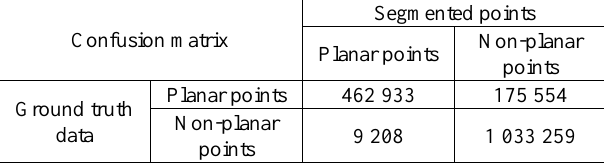
Table 3. Confusion matrix obtained by the proposed method